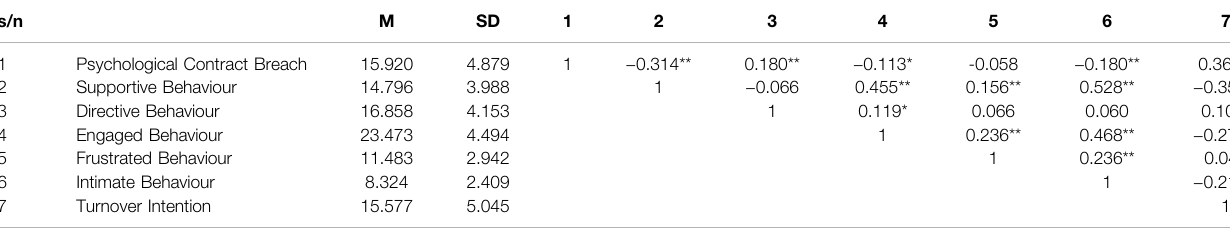
Note **p < 0 .001; *p < 0 .01.